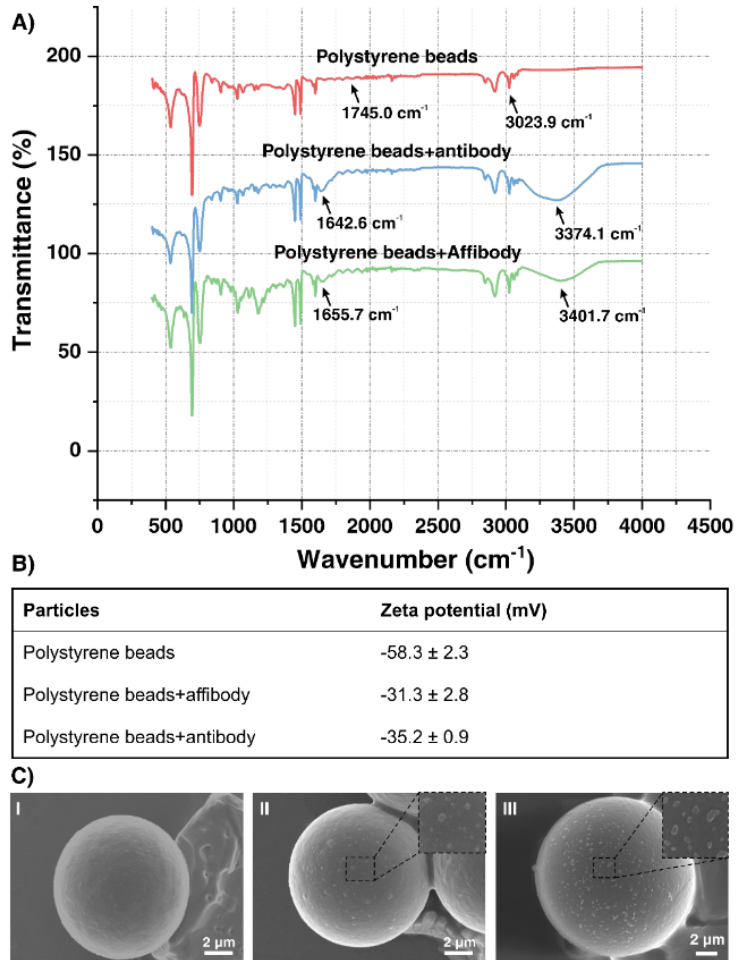
Figure 4. ( A ) FT-IR spectrum of the carboxyl polystyrene beads coated with Affibody (green graph) versus antibody-coated carboxyl polystyrene beads (blue graph), and carboxyl polystyrene beads (red graph). ( B ) Zeta potential analysis of carboxyl polystyrene beads coated with Affibody versus the antibody coated carboxyl polystyrene beads and carboxyl polystyrene beads. ( C ) Scanning electron microscope images of I polystyrene microbeads, II anti-EGFR antibody-coated microbeads with exosomes and III AffiBeads coated with exosomes at a 2000× magnification (scale bar: 2 µm) are shown.